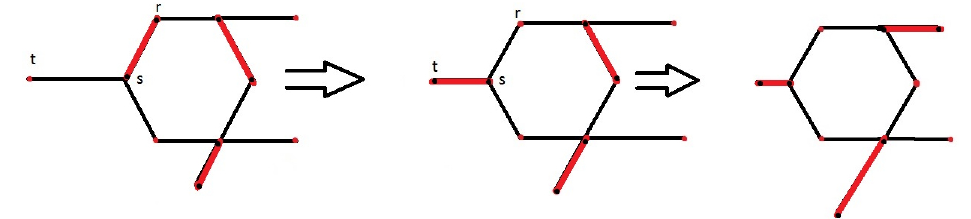
Figure 1. Covers of graph G .